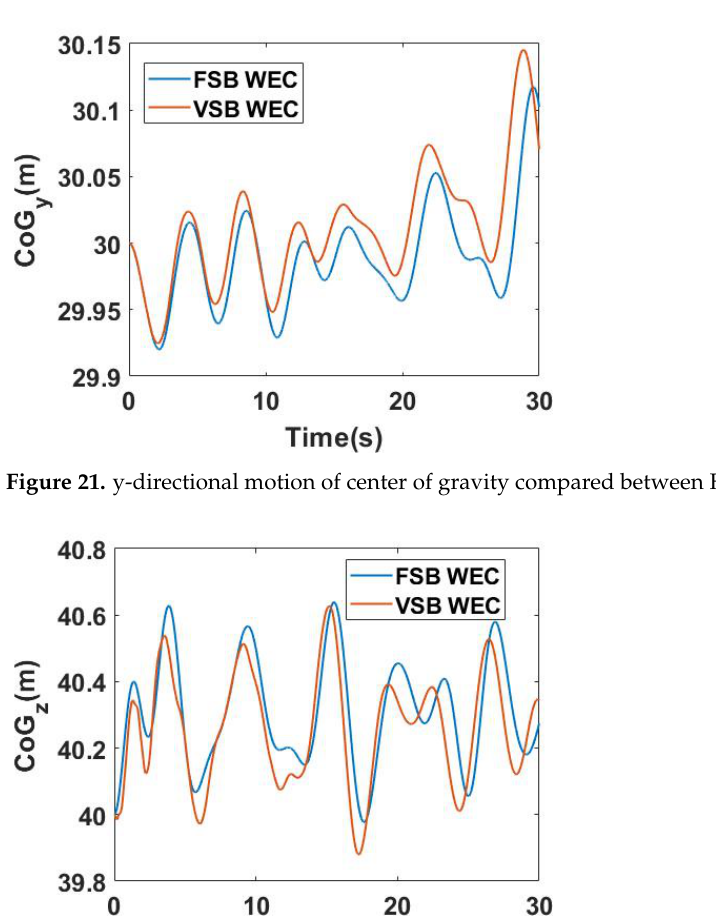
Figure 20. x-directional motion of center of gravity compared between FSB WEC and VSB WEC.